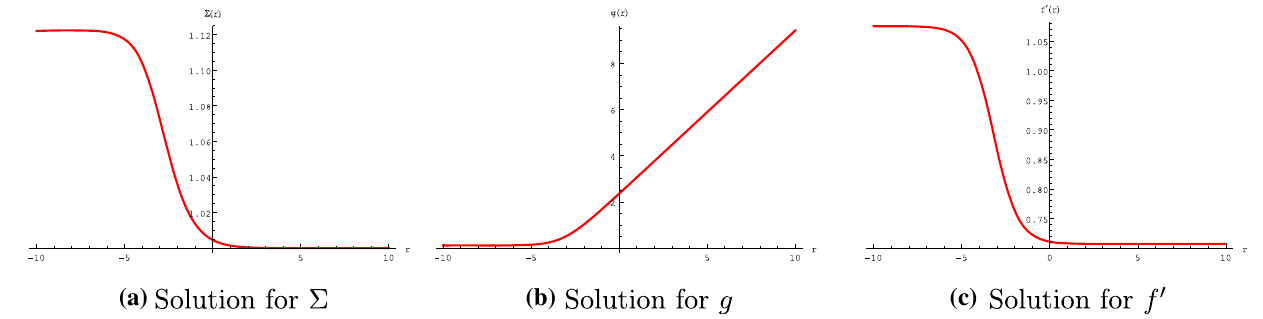
Fig. 9 An RG flow solution from supersymmetric AdS 5 with U ( 1 ) × SO ( 3 ) symmetry to AdS 3 × S 2 geometry in the IR for U ( 1 ) × SO ( 3 , 1 ) gauge group and g 1 = 1, a 5 = 1